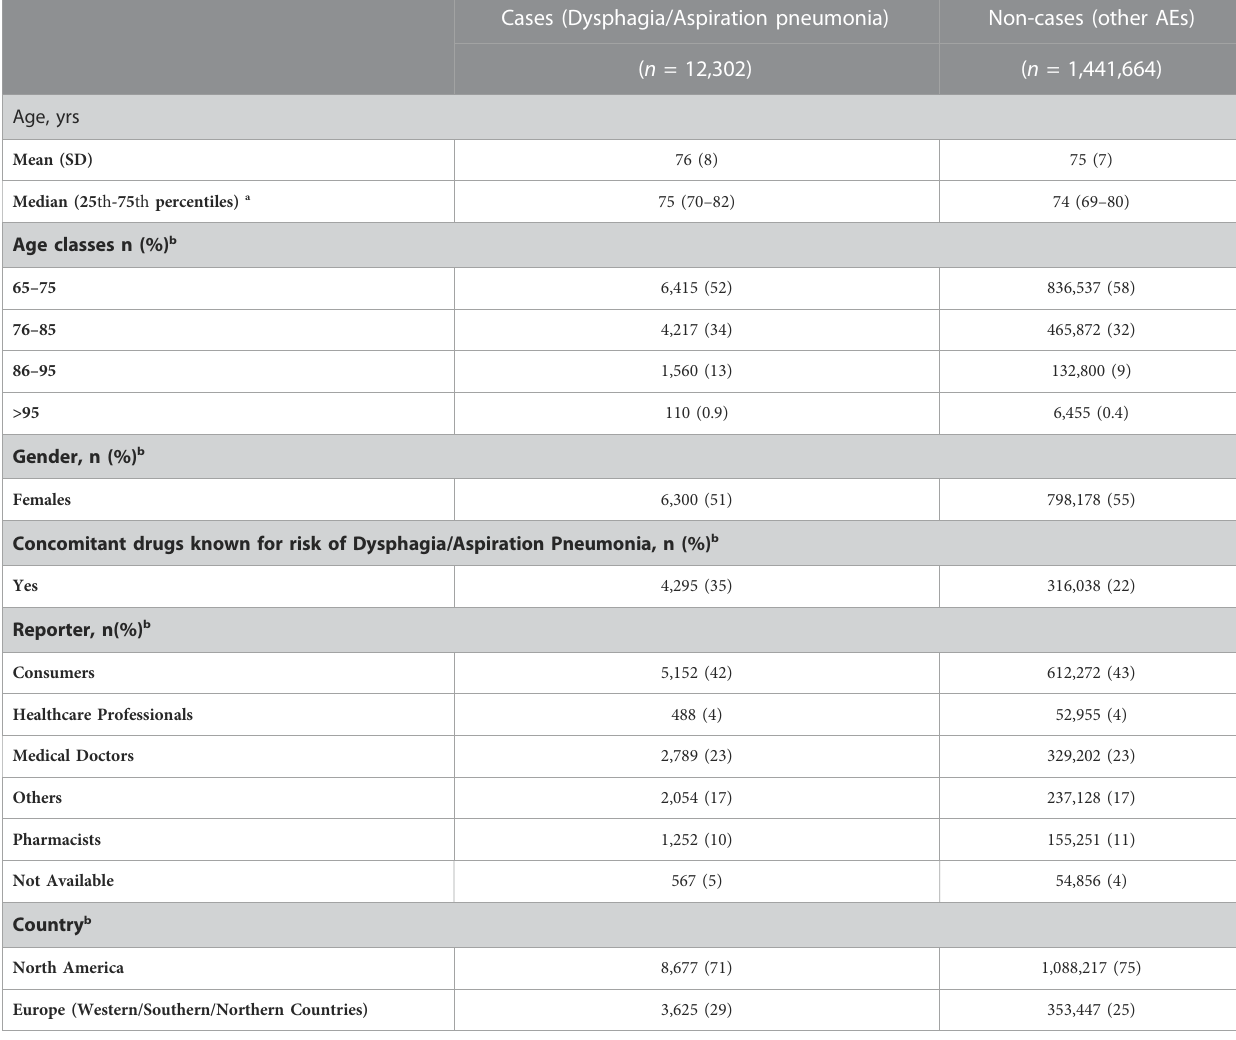
TABLE 5 Descriptive analysis of the Individual Case Safet Reports (ICSRs) retrieved from FAERS.